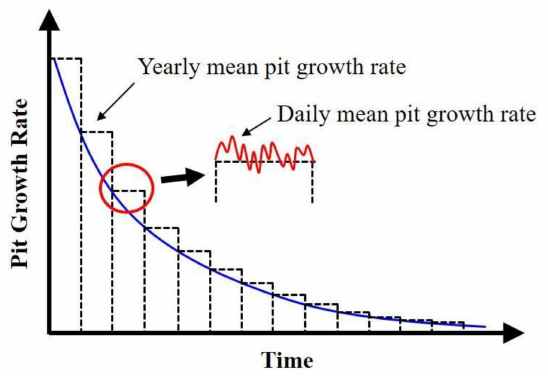
Figure 4. A schematic diagram of the model for pitting corrosion as a function of